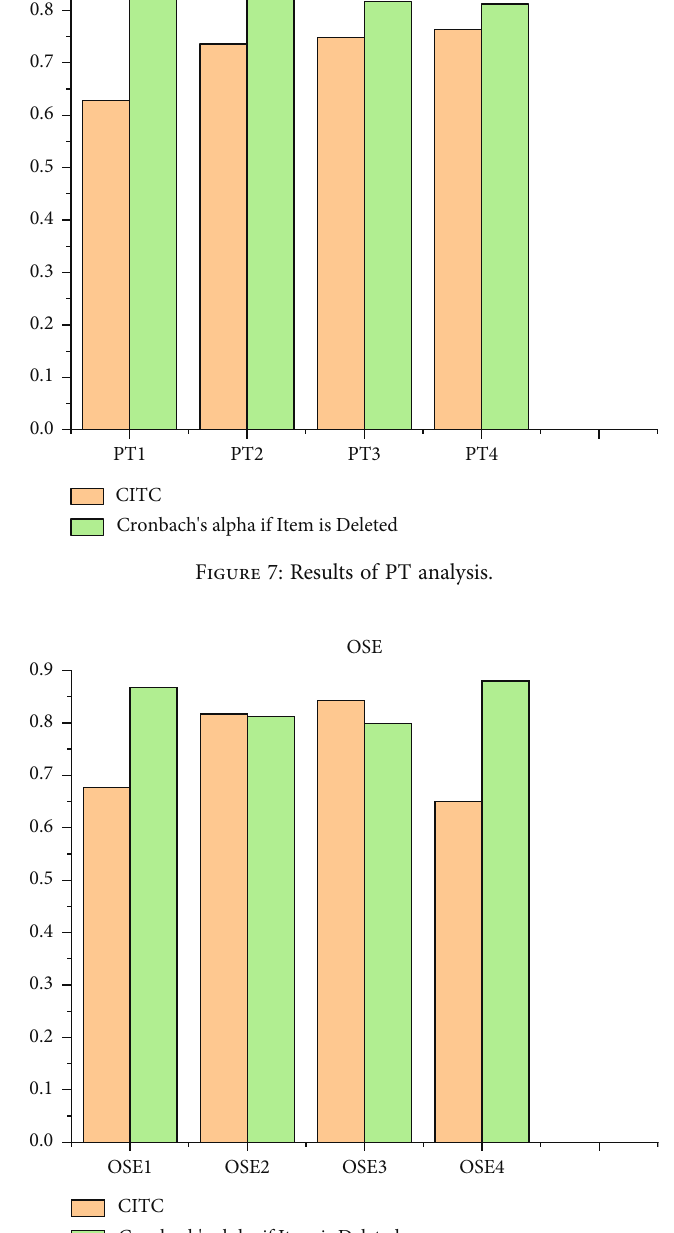
Figure 8: Results of OSE